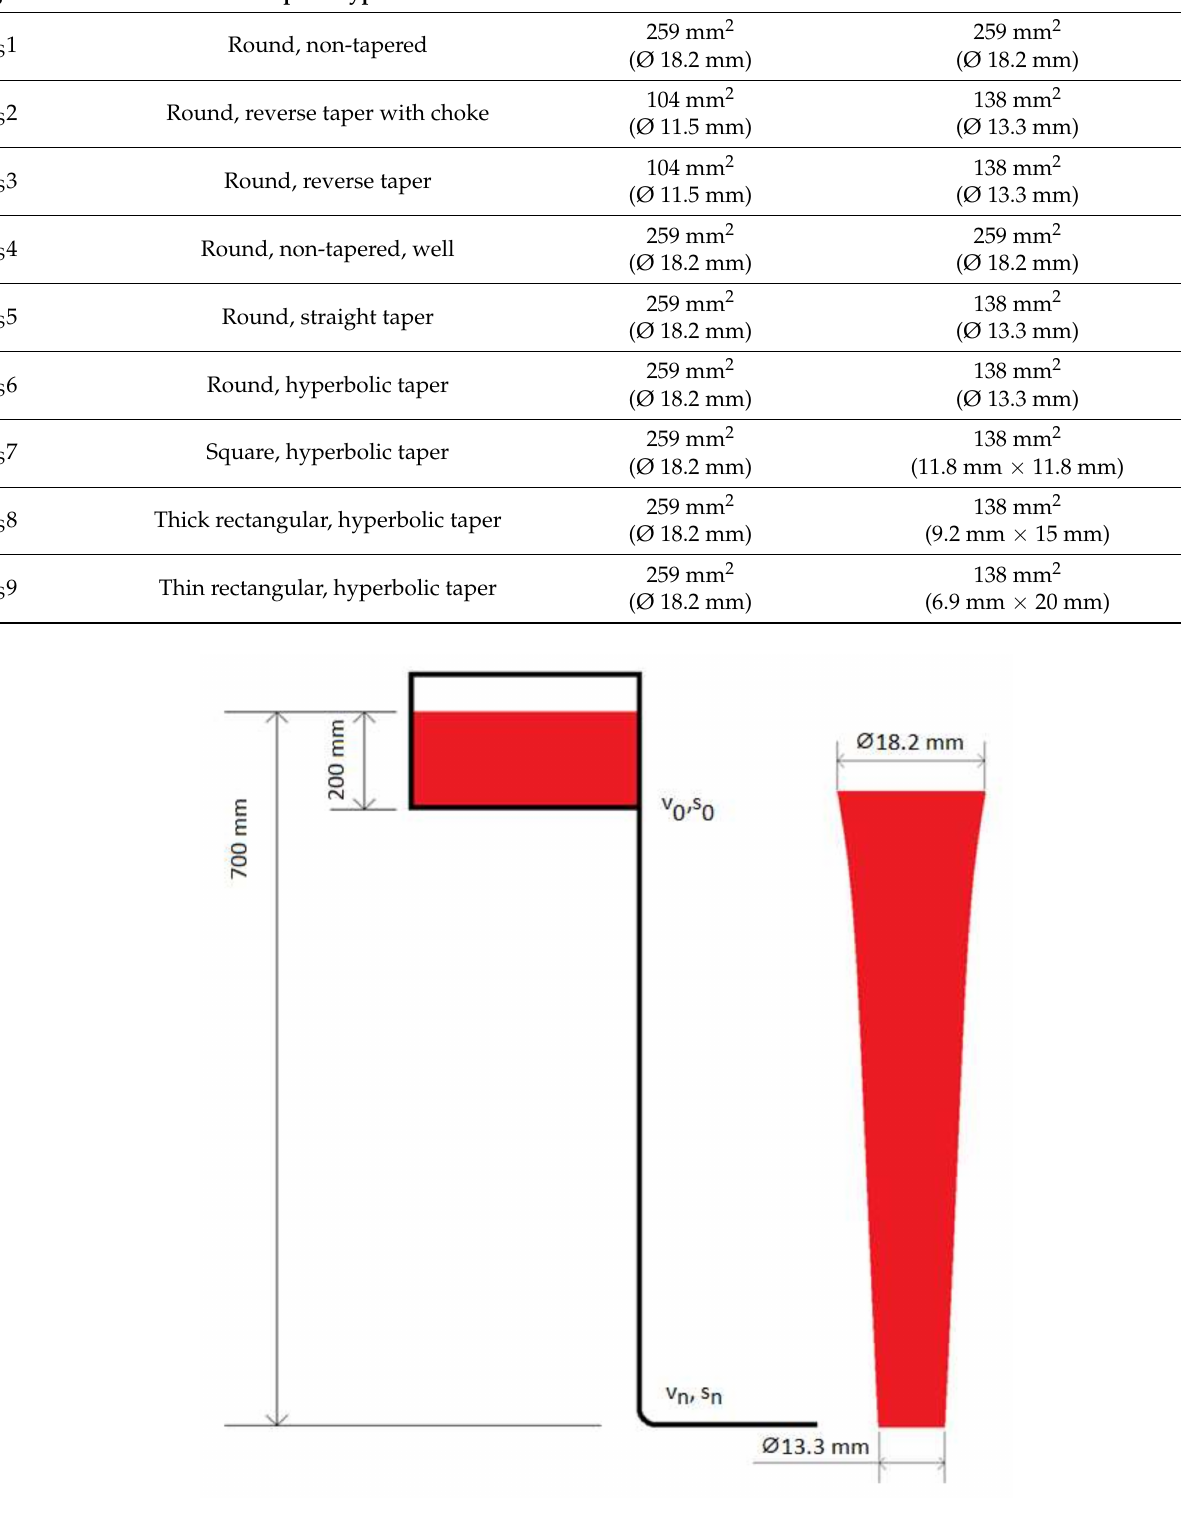
Figure 16. Schematic representation of the tested